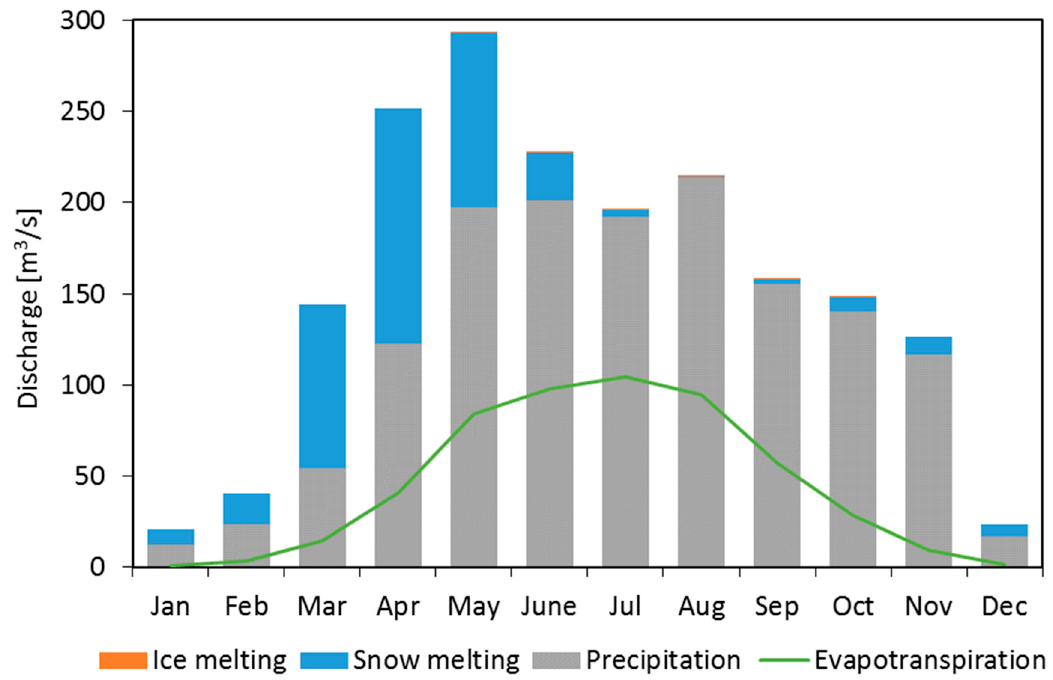
Figure 6. Monthly share of low components in Lake Como catchment. 2002–2018.